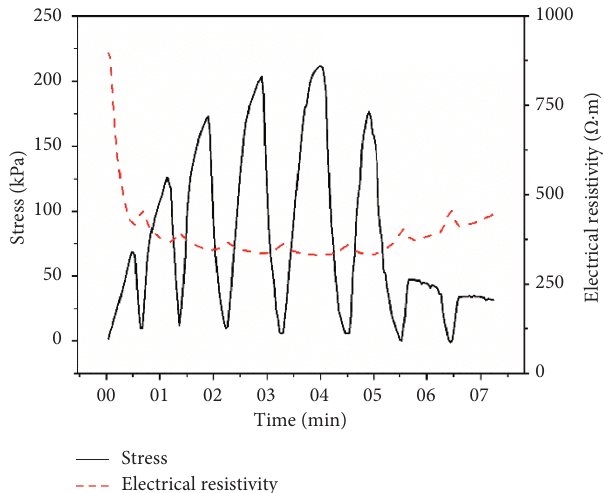
Figure 9: Strain-time-electric resistivity curve of loess under loading and unloading